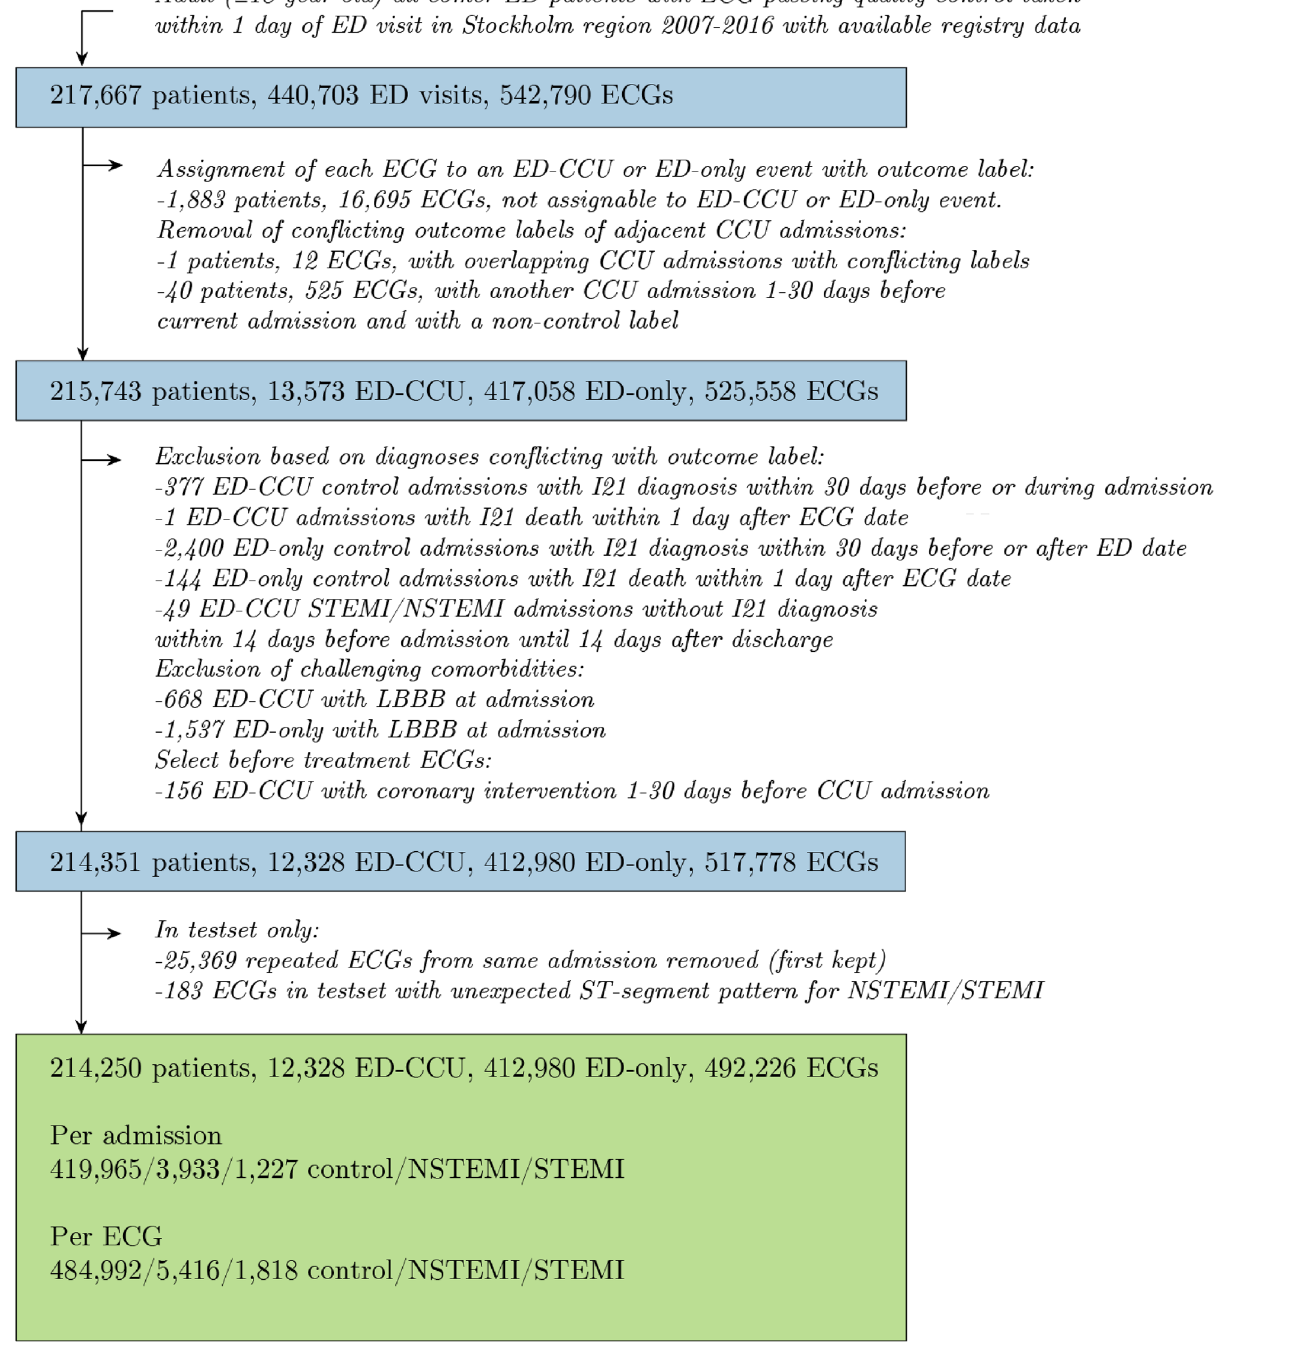
Figure 4. Derivation of the study sample. Inclusion/exclusion criteria applied to define the study sample. SWEDEHEART, Swedish Web-system for Enhancement and Development of Evidence-based care in Heart disease Evaluated According to Recommended Therapies; RIKS-HIA, Register of Information and Knowledge About Swedish Heart Intensive Care Admissions; CCU, coronary care unit; ED, emergency department; ED-CCU, ED visit with CCU admission with outcome label and ECG within 0–1 days prior to CCU admission and ED date within 0–1 days prior to CCU admission; ED-only, ED visit without any CCU admission within ± 30 days of ECG recording; NSTEMI, non-ST-elevation myocardial infarction; STEMI, ST-elevation myocardial